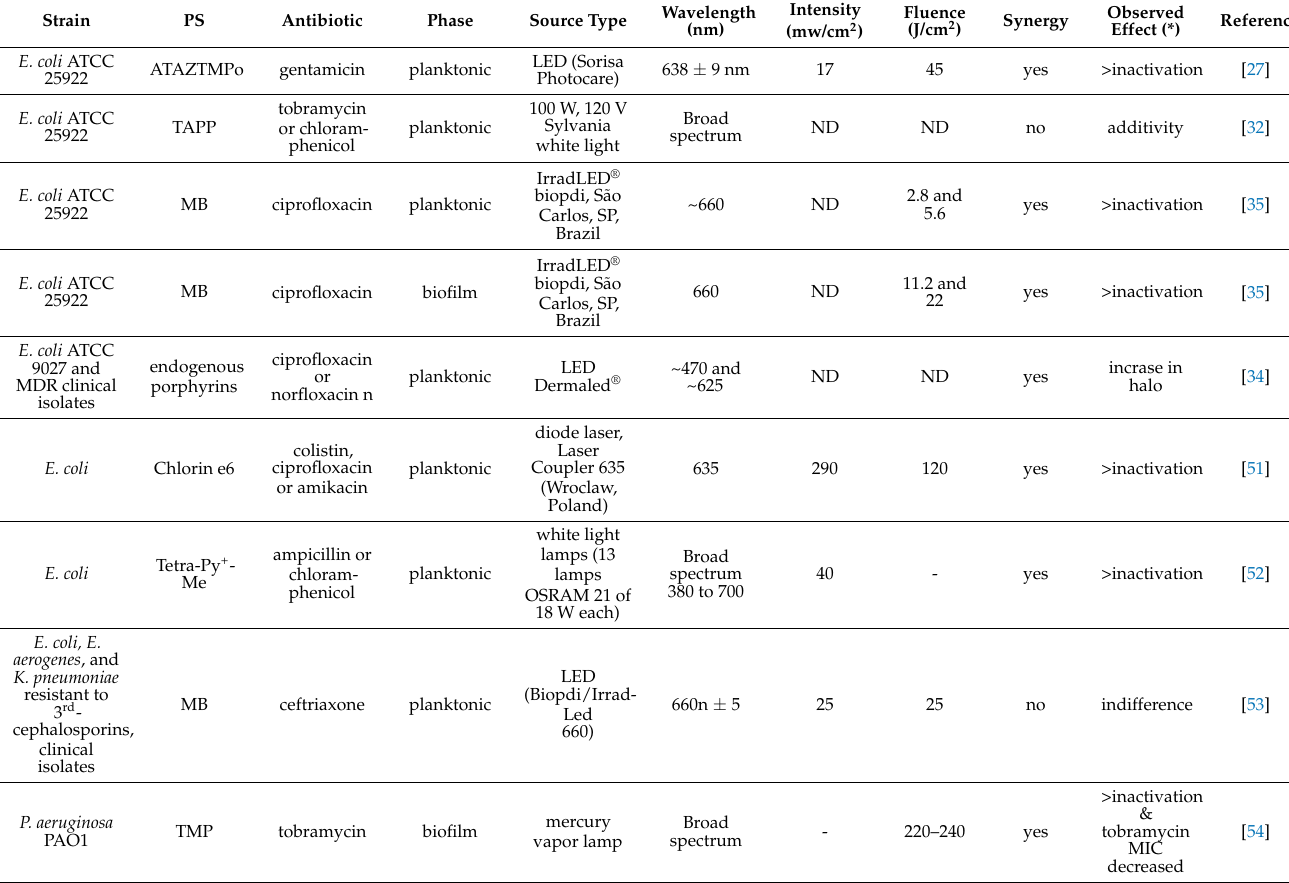
Table 4. Studies on combination of in vitro aPDT plus other treatment against Gram-negative bacteria that cause SSTIs comparing the methodology and the